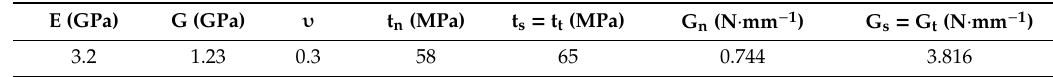
Table 3. Mechanical properties of adhesive.